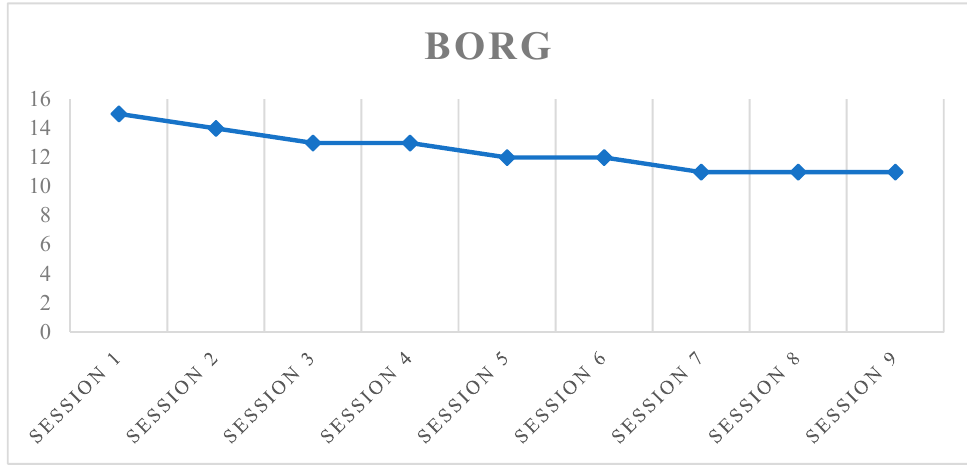
Figure 5. Trend of the Borg score.